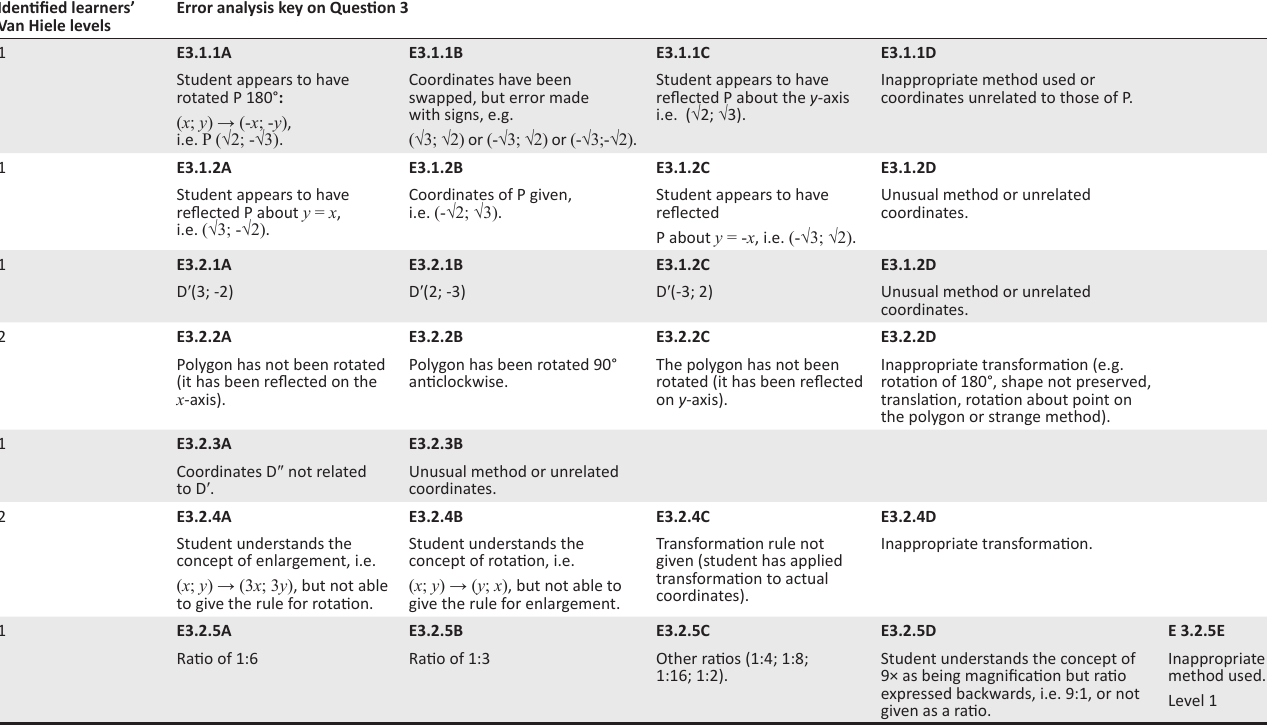
TABLE 2: Explanations of students’ average errors on each of the seven parts of Question 3 and the resultant Van Hiele classification. Identified learners’ Van Hiele